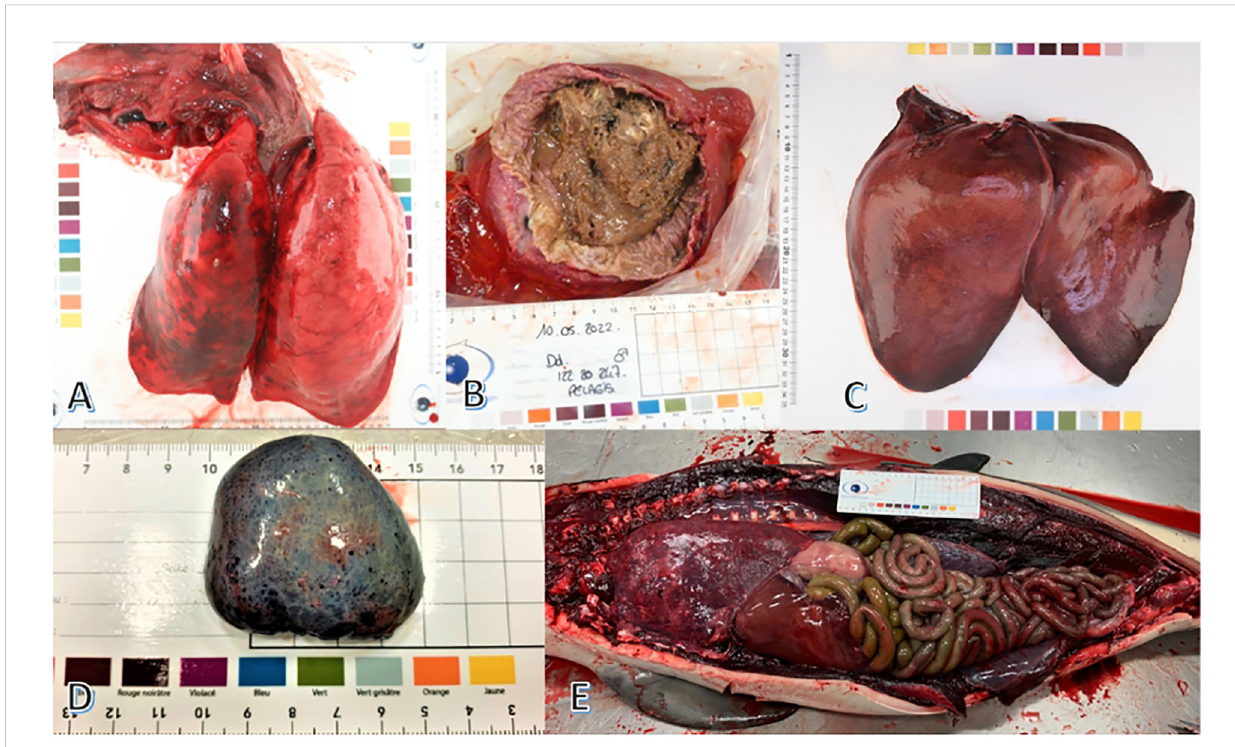
FIGURE 4 Organs described and photographed at L2 in a cetacean, (A) lungs, (B) gastric contents, (C) liver, (D) spleen, (E) thoracic and abdomen topography, ©